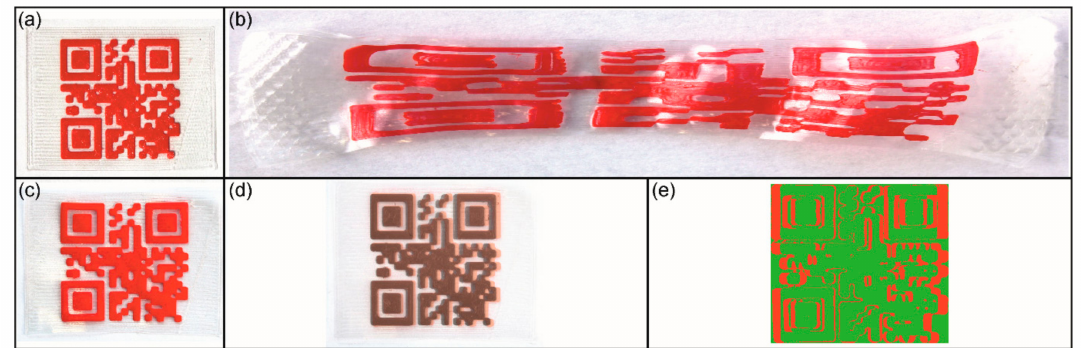
Figure 10. Type 2 QR code carrier: Permanent shape after 3D printing ( a ), the temporary shape as obtained after programming ( F max = 25 N) ( b ), and the recovered shape after heating to 60 ◦ C ( c ). To visualize shape recoverability, the image of the permanent shape was converted to black-and-white and superimposed with a transparency of 60% on the image of the recovered shape ( d ). The result of a mathematical calculation comparing the permanent shape with the recovered shape: congruent areas (green color) and incongruent areas (red color) ( e